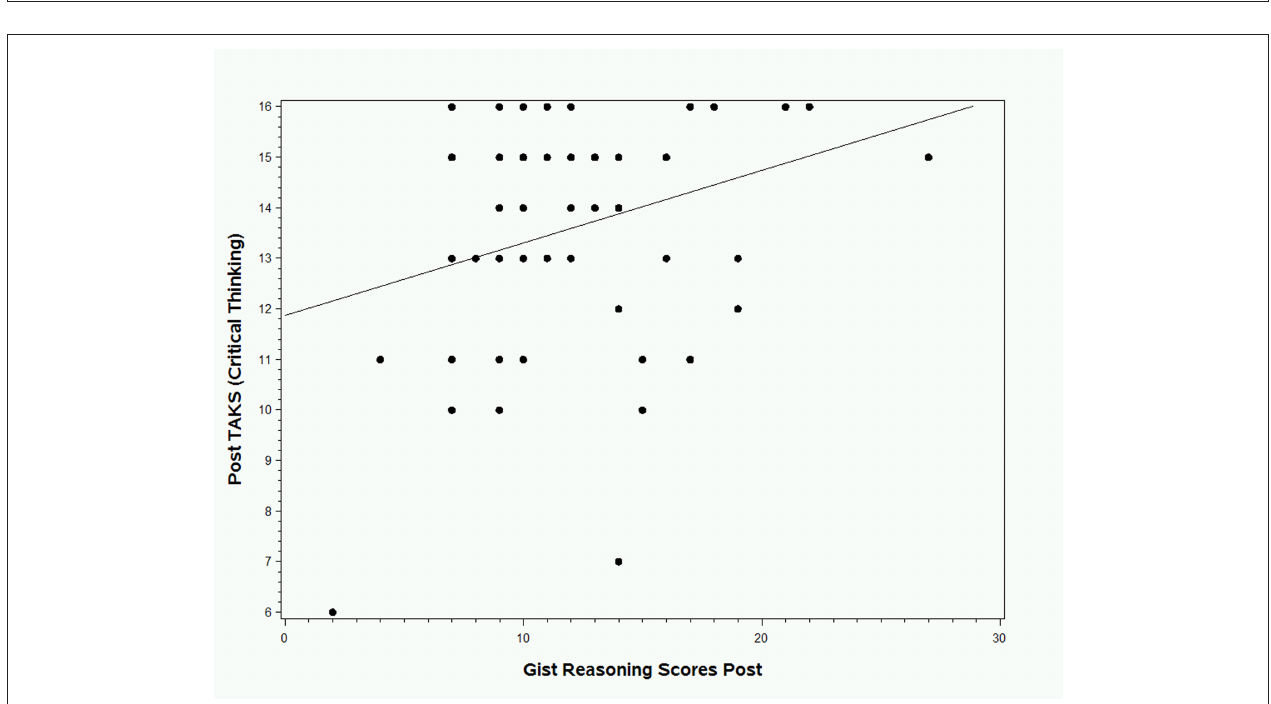
FiGuRe 4 | Positive correlation between gist-reasoning scores and TAKS critical thinking